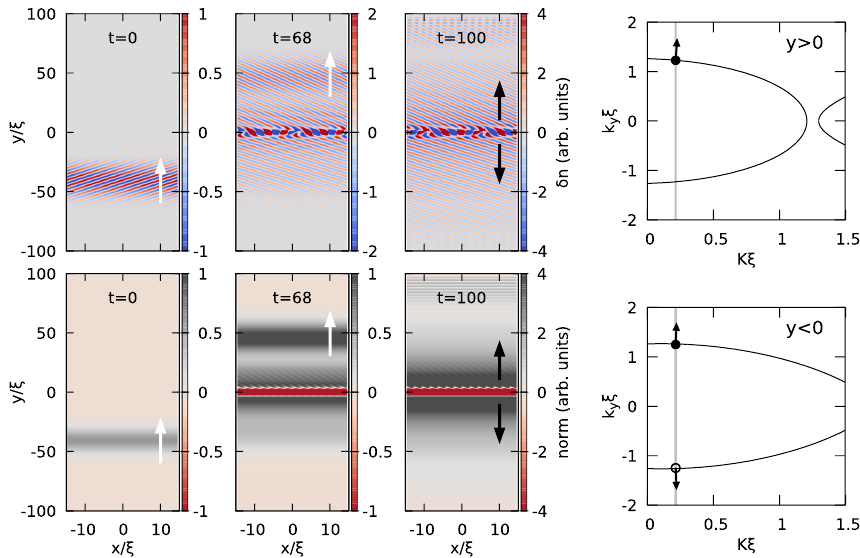
Figure 10: Same calculation as in Figures 8 and 9 for different values of ∆ v = 3.14 c and ω = 0.5 µ/ ħ h . Here only positive-energy modes are available in the two asymp- totic regions, so that scattering results in an amplified transmission together with the seeding of the RI. The white arrows indicate the direction of motion of the incident and transmitted wavepackets, while the black arrows indicate the propagation direc- tion of the phononic waves due to the